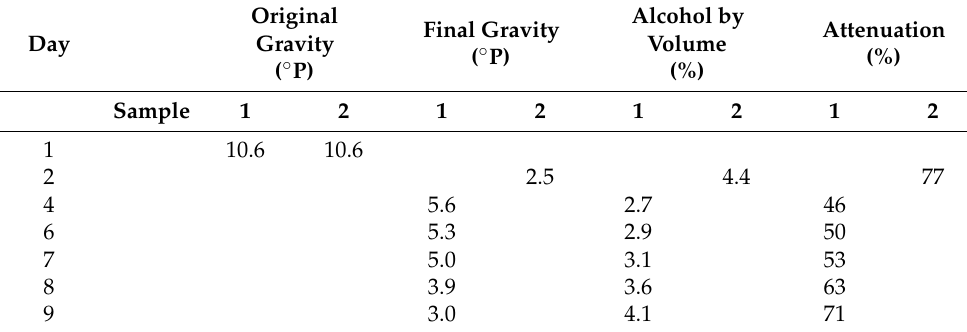
Table 2. Monitoring of fermentation